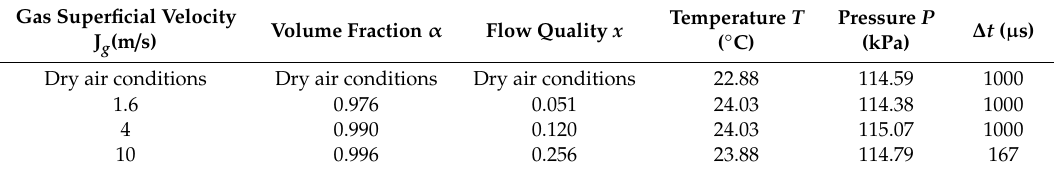
Table 2. Input conditions used in the ex-situ experiments (liquid superficial velocity was kept at J (cid:96) = 0.04 m /